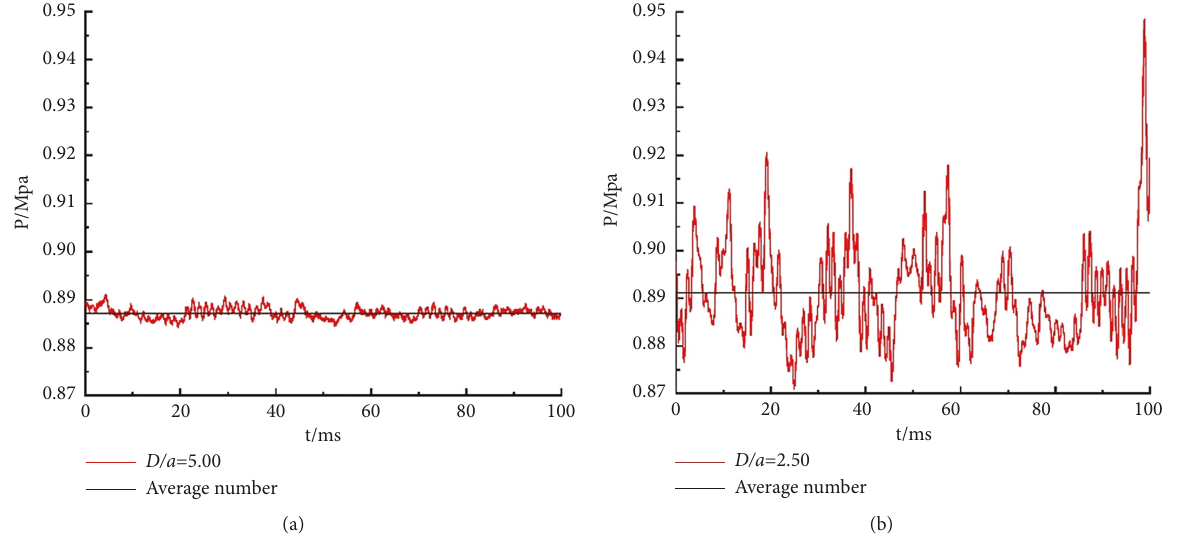
Figure 19: The pressure pulsation of the cleaning target. (a) D/a